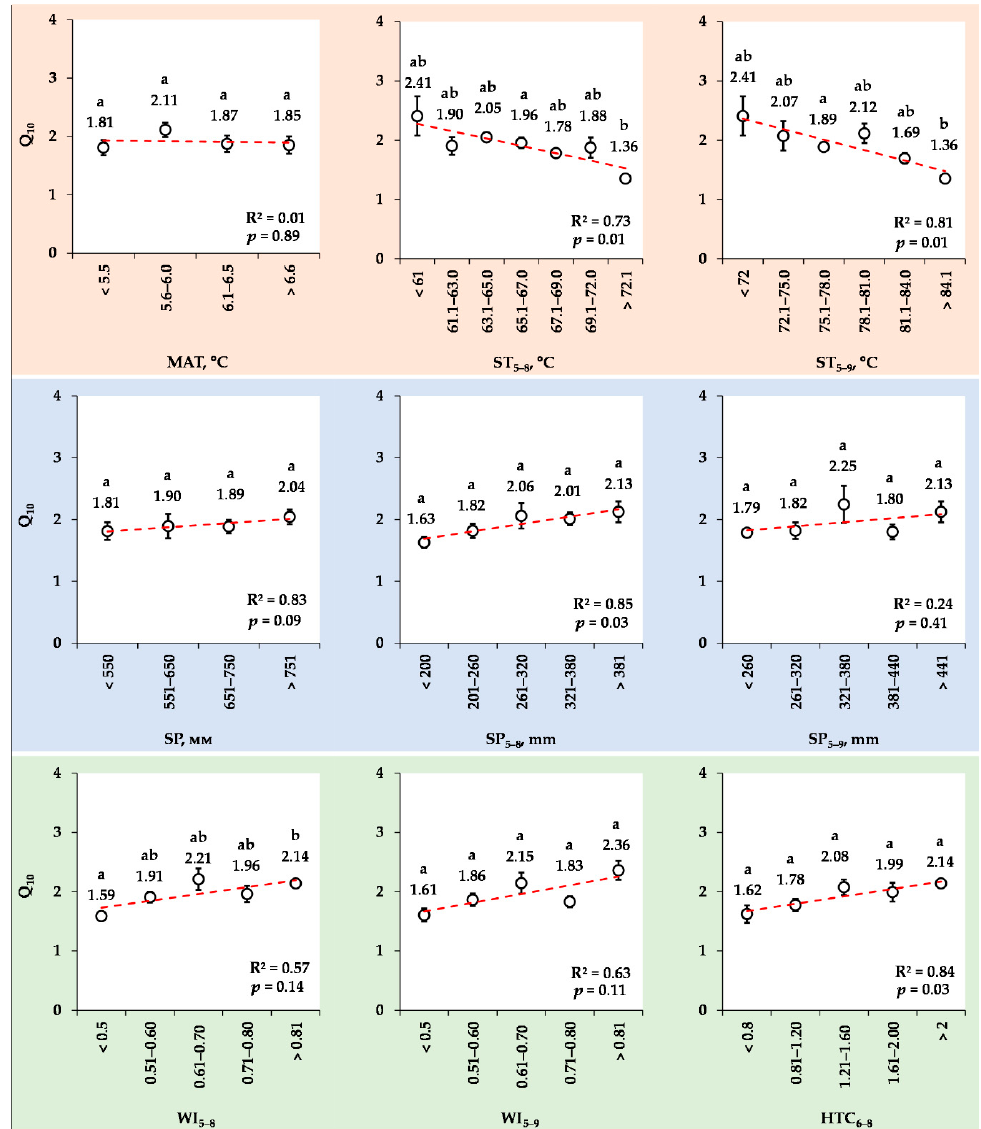
Figure 9. Rank correlations between the mean Q 10 values in the loamy Haplic Luvisol and the meteorological indexes: MAT, °C mean annual Tair; ST 5–8 and ST 5–9 (°C) are the sums of the mean monthly Tair from May to August and May to September, respectively; SP is the annual sum of precipitation (mm); SP 5–8 and SP 5–9 are the sums of the monthly precipitation from May to August and May to September, respectively; WI 5–8 and WI 5–9 are the wetness indexes from May to August and May to September, respectively; HTC 6–8 is the hydrothermal coefficient over the summer period (June–August). Letters indicate significant differences at p <